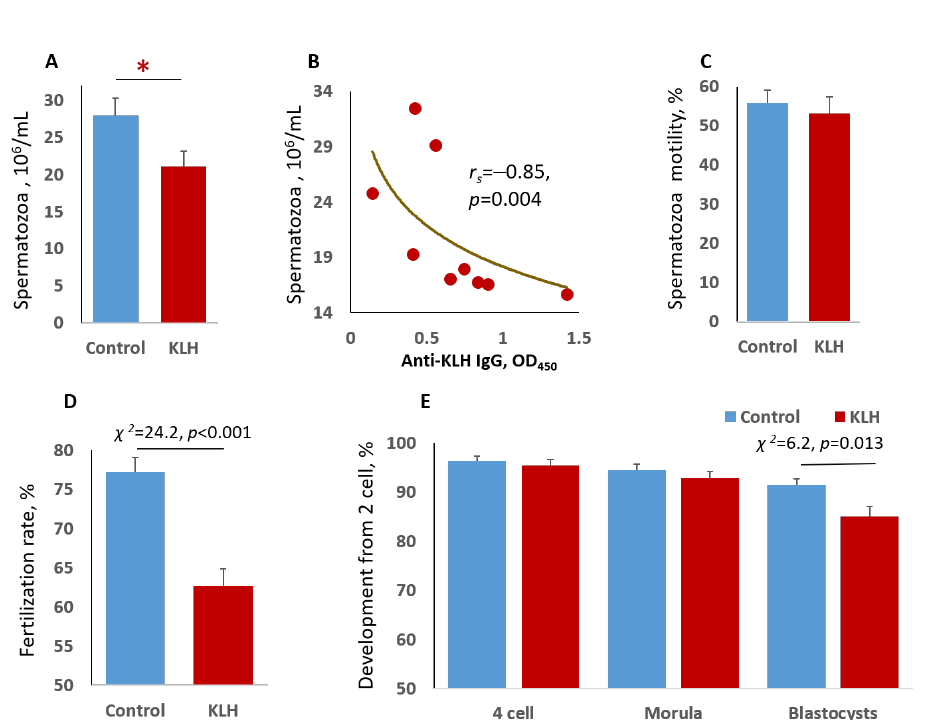
Figure 1. Effects of immunization on the number, motility, and in vitro fertilization rate of spermatozoa from control and KLH CD1-treated male mice. ( A ) Sperm concentration differed significantly between groups. * Student’s t -test, p < 0.05. ( B ) Correlation of sperm concentration and serum anti-KLH IgG in KLH-treated males. ( C ) Percentage of motile sperm. ( D ) Fertilization rate expressed as a percentage of two-cell embryos out of the total number of oocytes (496 in control and 490 in the KLH-treated groups). ( E ) Percent of embryos developed in vitro from two cells ( n = 383 in control and n = 307 in the KLH-treated groups) to blastocysts. Between-group differences were evaluated by χ 2 -test in ( D , E